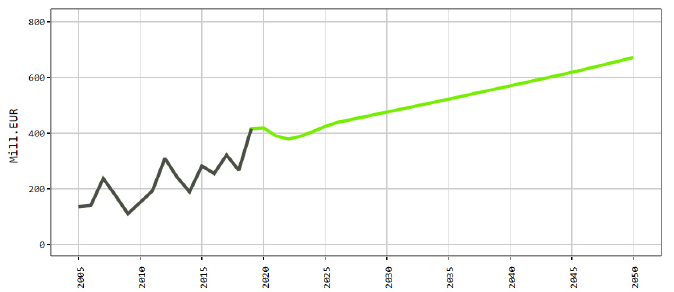
Figure 20. Value added in the main sectors of agriculture in 2005–2019, and a 2020–2050 projection for Latvia, in millions of EUR [62].